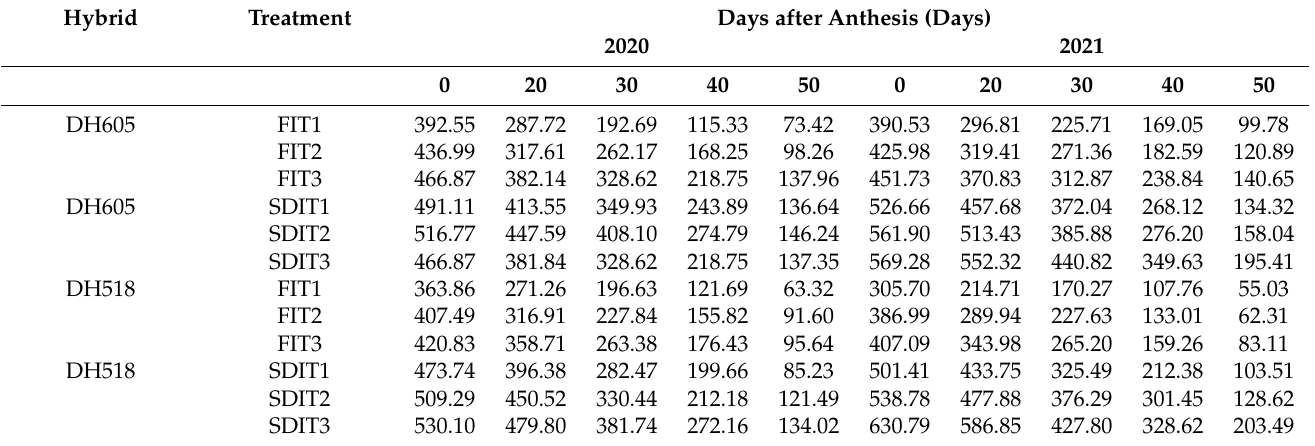
Table 7. Stomatal conductance (G s ) of two corn hybrids differing in maturity under different irrigation treatments ( µ mol H 2 O/(m 2